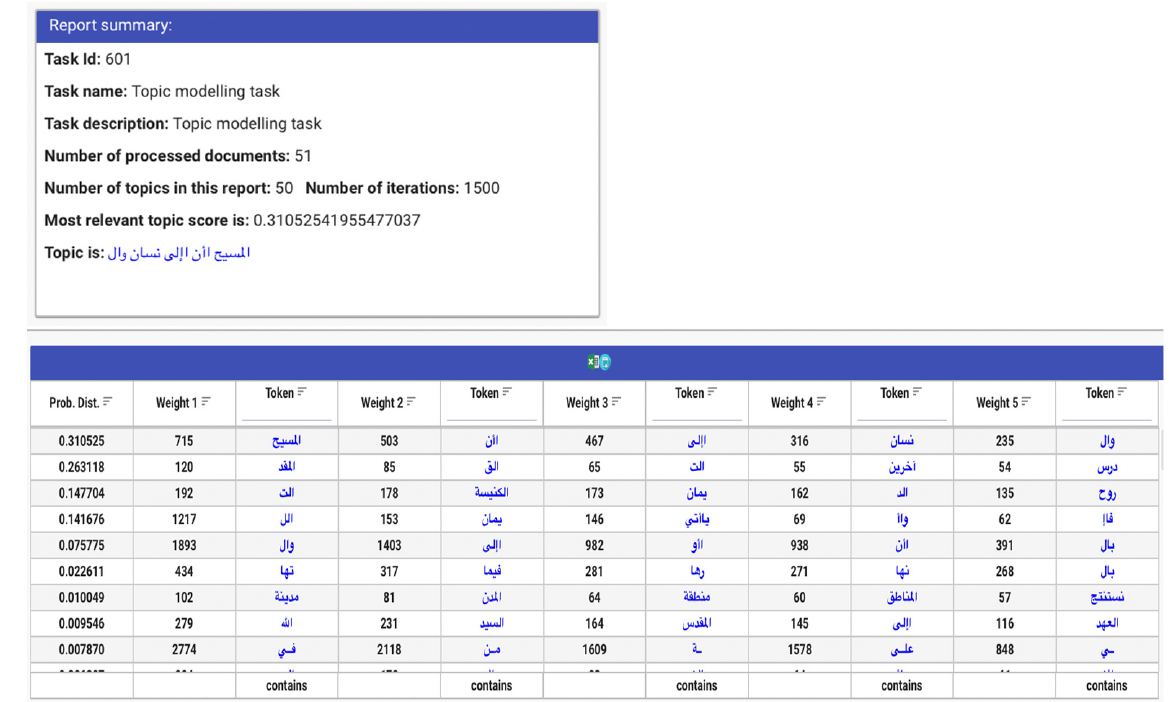
Figure 4. Project summary dashboard.